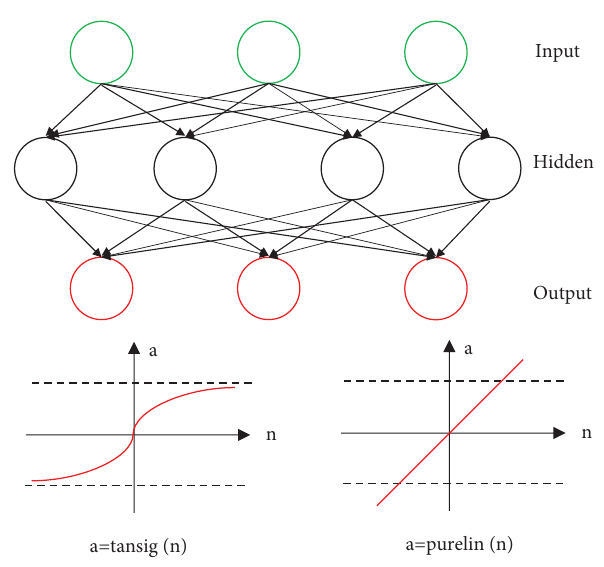
Figure 3: ANN structure